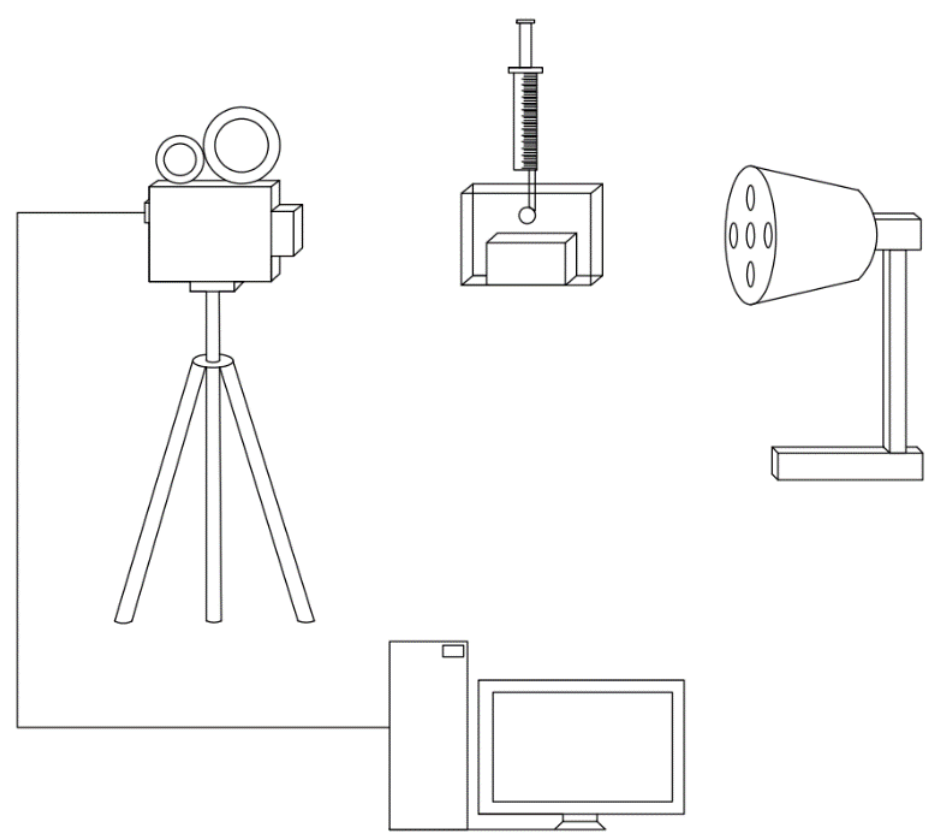
Figure 3. Schematic diagram of high-speed camera shooting.